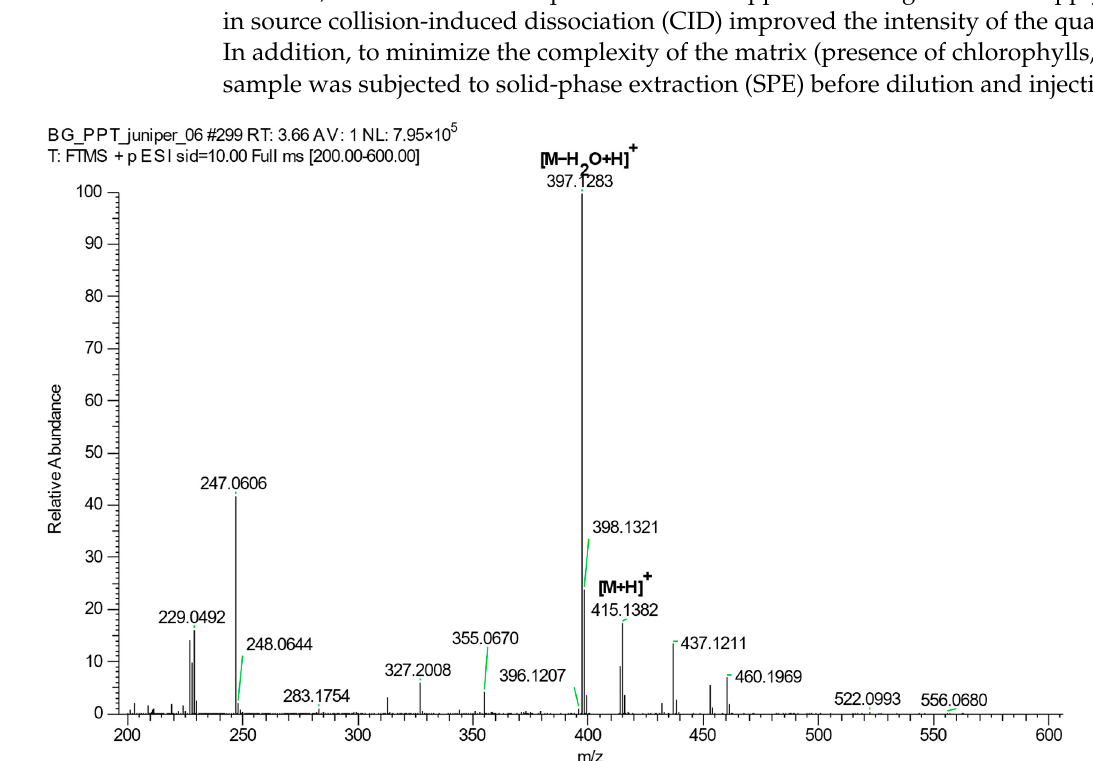
Table 6. Linearity parameters of the PPT calibration curve and limits of detection and quantifica- tion.